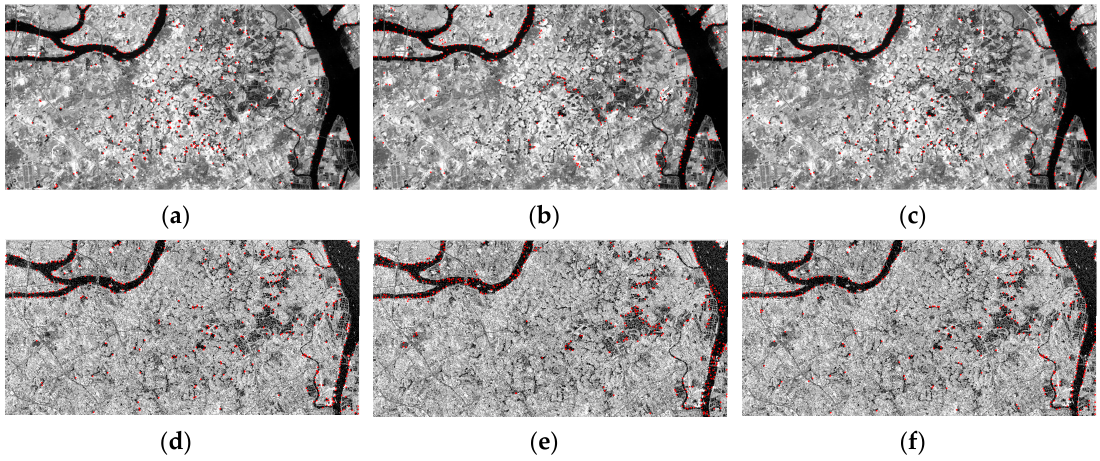
Figure 10. Feature-based preregistration results using different edge points extraction methods for the No. 1 image pair. ( a , d ) use the Canny algorithm to obtain edge points; ( b , e ) use the phase convergence model to obtain edge points; ( c , f ) use the ANDD-based ESM to obtain edge points.